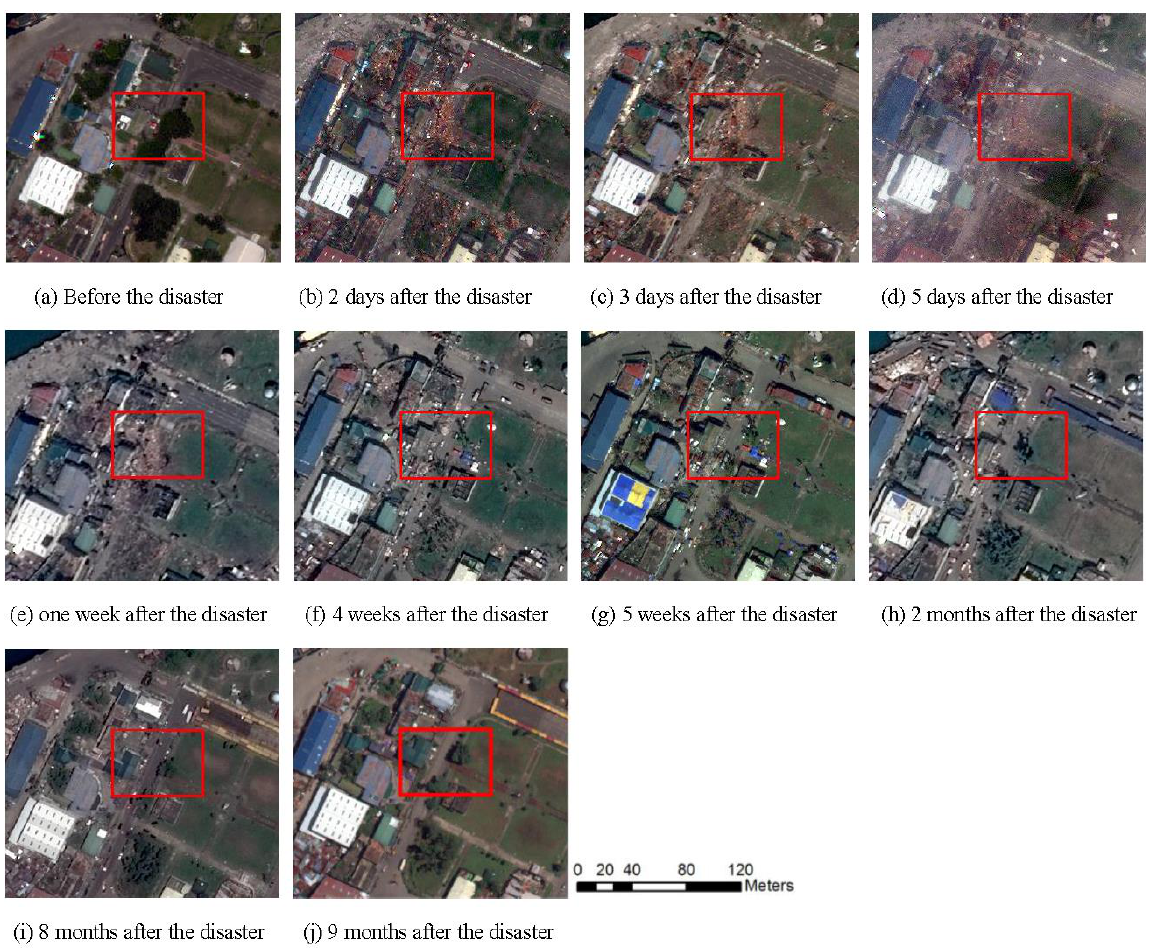
Figure 3. a-j) Very high resolution satellite images respectively for before disaster, 2, 3, 5, 7 days, 4 and 5 weeks, and 2, 8 and 9 months after the